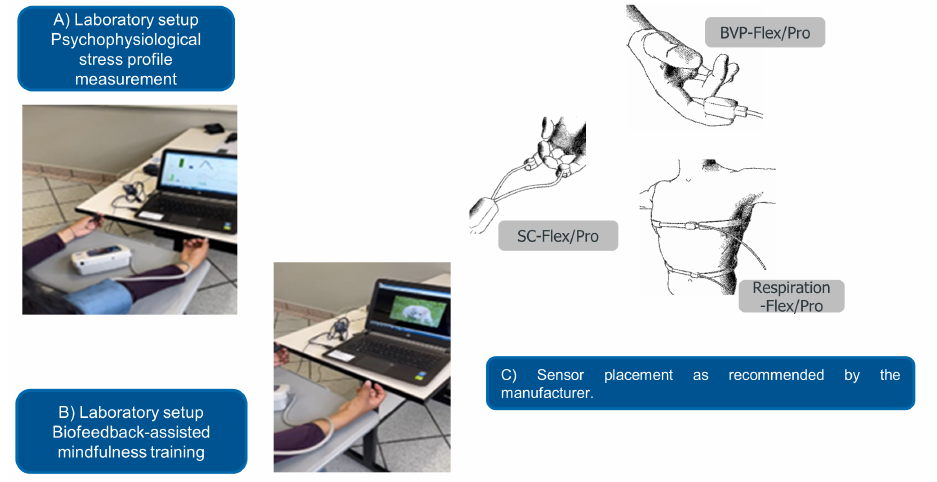
Figure 2. Laboratory setup. ( A ) Psychophysiological stress profile measurement. ( B ) Biofeedback- assisted mindfulness training session. ( C ) Sensor arrangement as suggested by the manufacturer. Images taken from the ProComp5 InfinitiTM Hardware Manual with permission of Thought Technol- ogy, Montreal, QC, Canada. www.thoughttechnology.com (accessed on 21 December 2022).